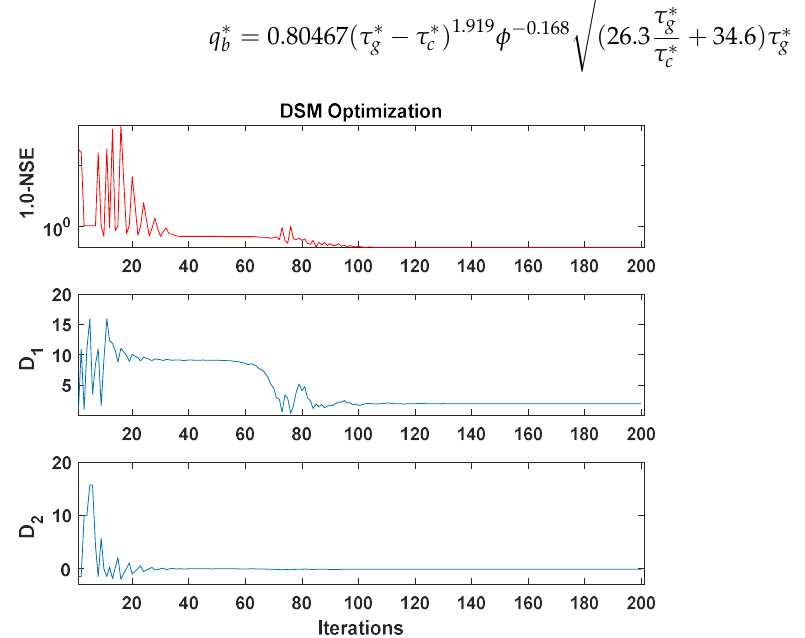
Figure 9. DSM optimization results for Equation (27) by minimizing 1.0−NSE (or maximizing NSE).